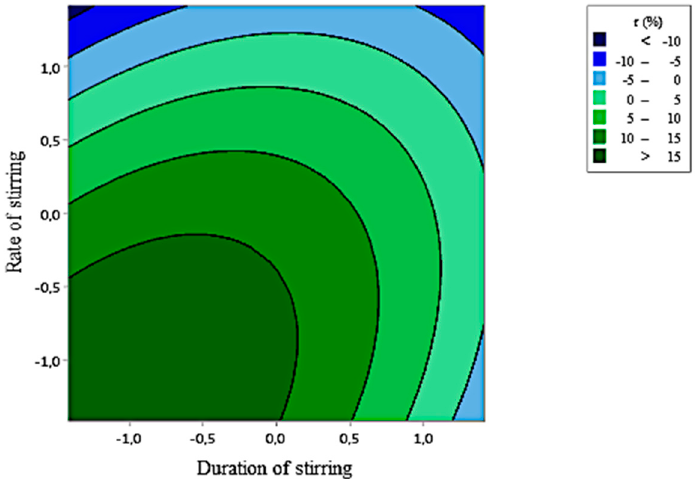
Figure 7. Contour plots showing the crossed effect of duration (D) and rate of stirring (R) on the retention rate (r) of citronella essential oil by GD-PAMAM-2.